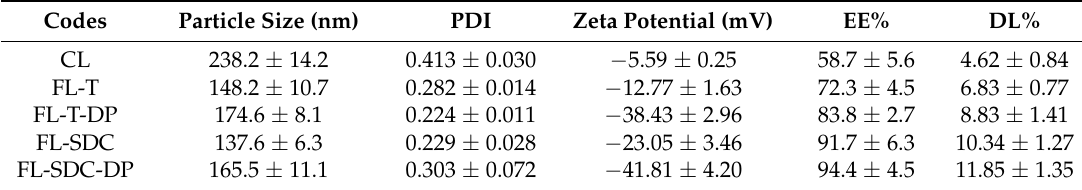
Table 3. Physicochemical characteristics of docetaxel (DXT)-loaded liposomes.